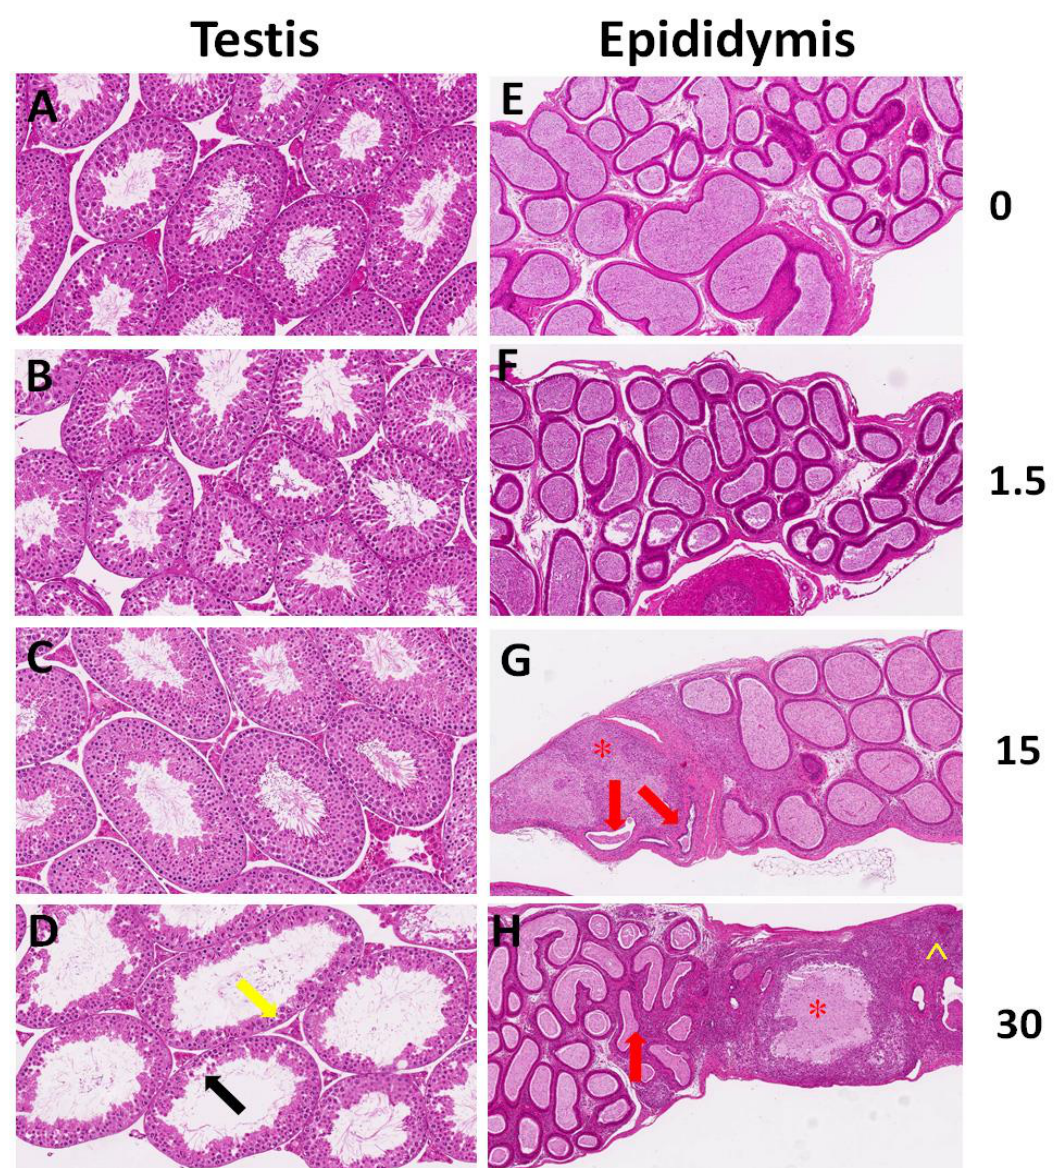
Figure 2. Histological analysis of the testes and epididymis of the BDE-47-treated mice. ( A – D ) Representative images of the testis sections. Black and orange arrows indicate necrotic spermatogenic cells and attenuated seminiferous epithelium, respectively. ( E , F ) Representative images of the epididymis sections. ( G , H ) Red arrows indicate reduced sperm in the epididymal lumens; asterisk (*) indicates spermatic granulomas; and carets (ˆ) represent suppurative inflammation. Images were obtained at an original magnification of 20 ×